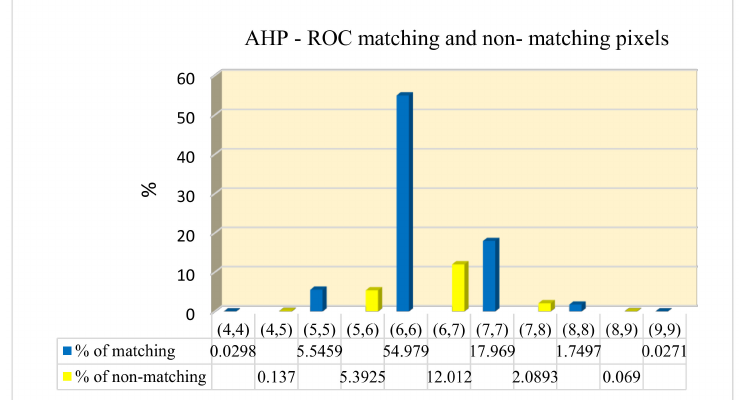
Figure 11. The percentage of matching and non-matching classes of suitability index pixels